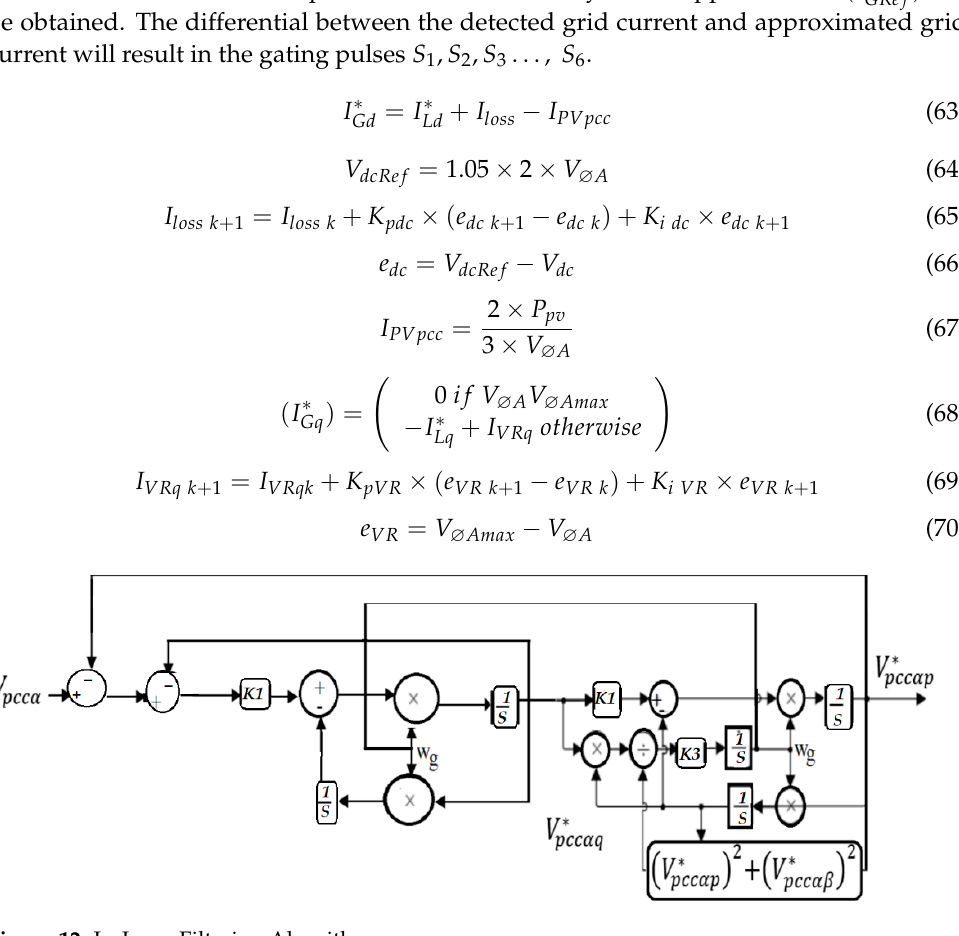
Figure 12. In-Loop Filtering Algorithm.